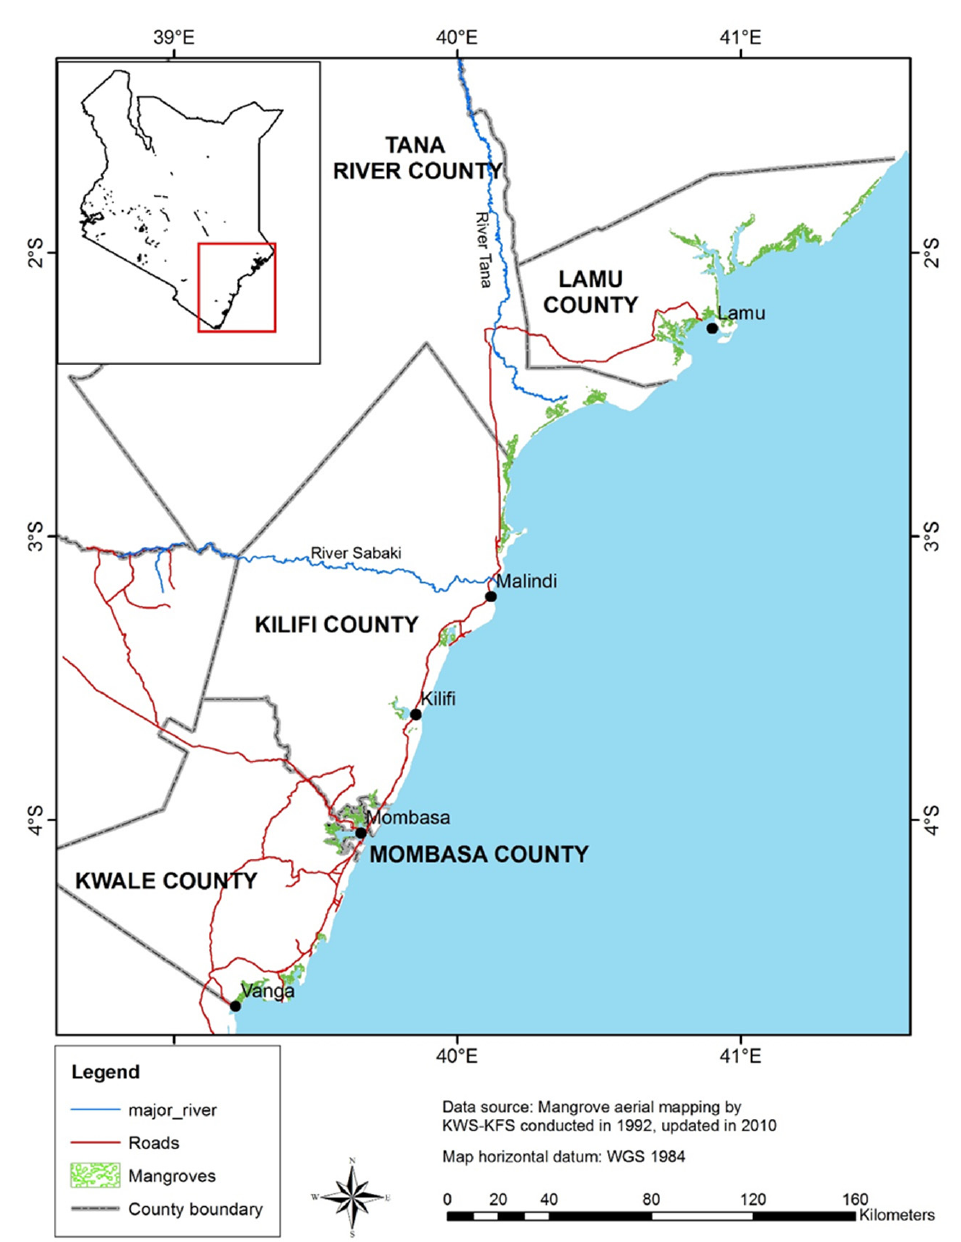
Figure 1. Kenyan coastline showing major mangrove areas in Lamu, Tana River, Kilifi, Mombasa, and Kwale Counties in 2010.